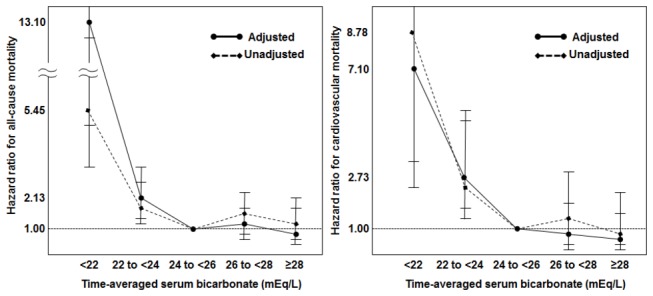
Hazard ratios for all-cause (right) and cardiovascular (left) mortality in each of the five time-averaged serum bicarbonate (TA-Bic) subgroups.Error bars indicate 95% confidence intervals for unadjusted and adjusted models. The subgroup with TA-Bic levels of 24-26 mEq/L was the reference group in all models.